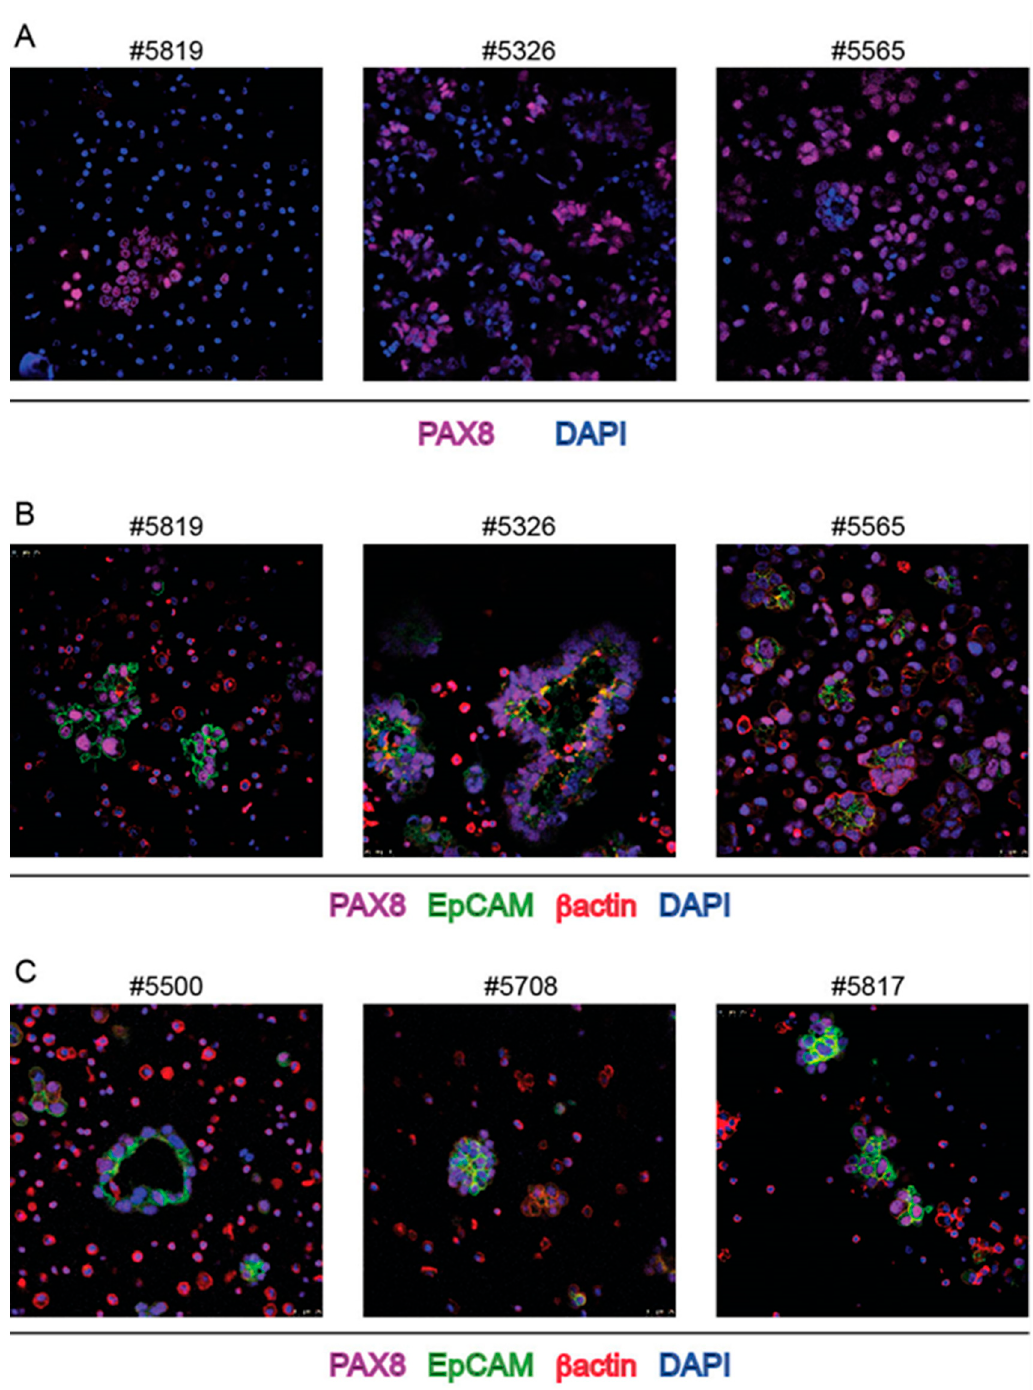
Figure 2. IF staining of spheroids from bulk ascites samples with PAX8, EpCAM and β actin MAbs. ( A , B ): three independent cases stained with the indicated MAbs; ( C ): ascites samples from three successive withdrawals of ascites of the same patient stained with the indicated MAbs. Numbers on top of each panel correspond to the Profiling protocol numbers of the collected ascites. Details of each #case are in Supplementary Table S1.